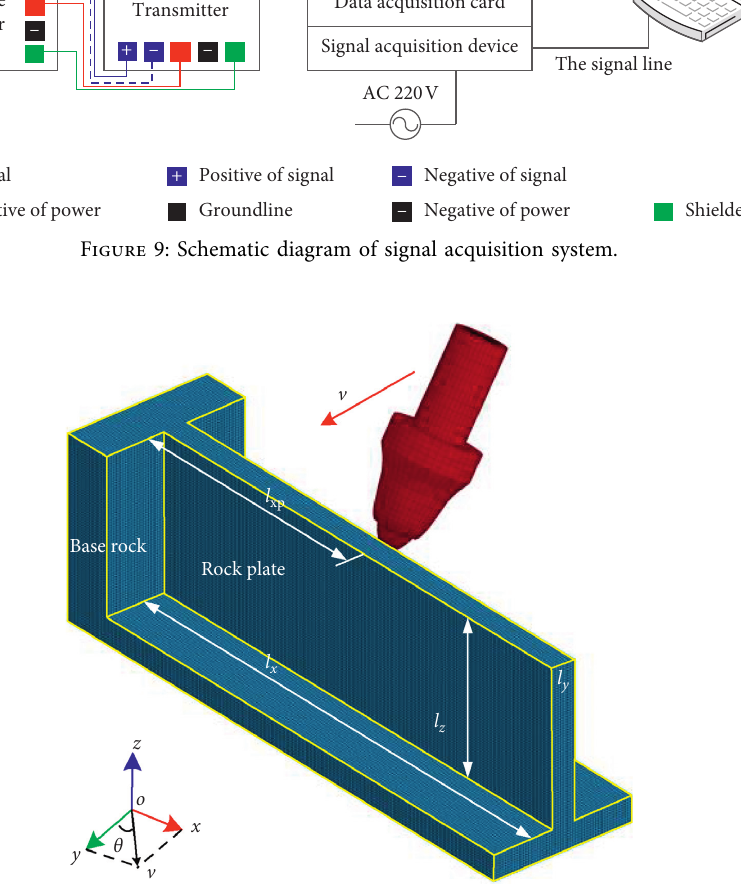
Figure 10: The numerical model between conical pick and rock plate. Table 2: Parameters of JHC for